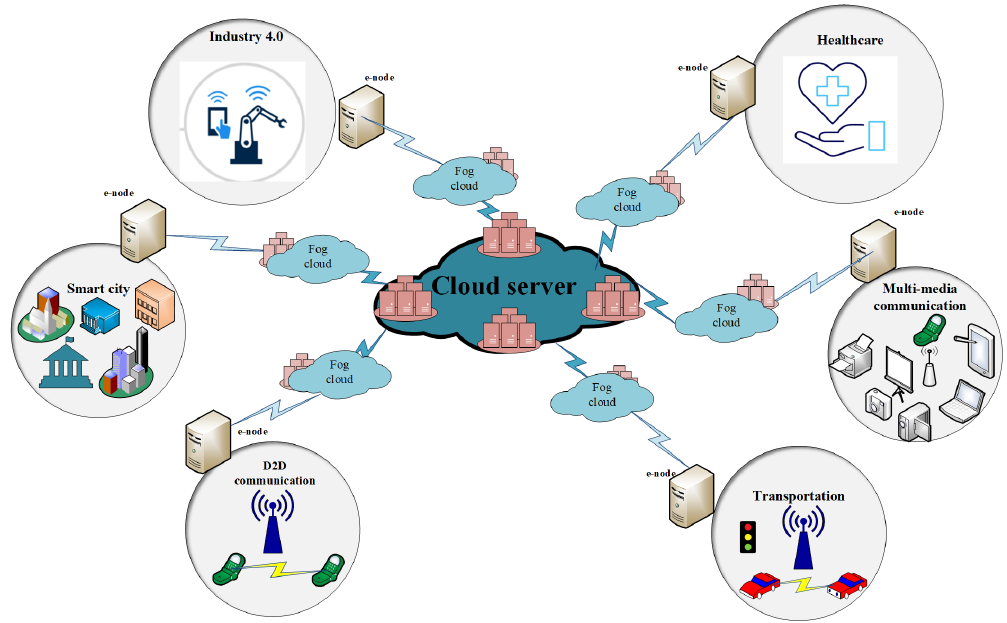
Figure 1. Generalized view: IIoT application domains with cloud, fog and edge computing.